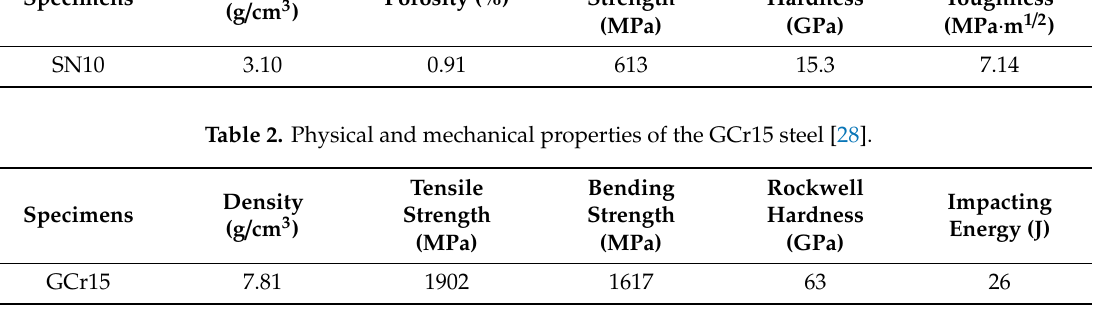
Table 3. Chemical composition of the GCr15 steel.